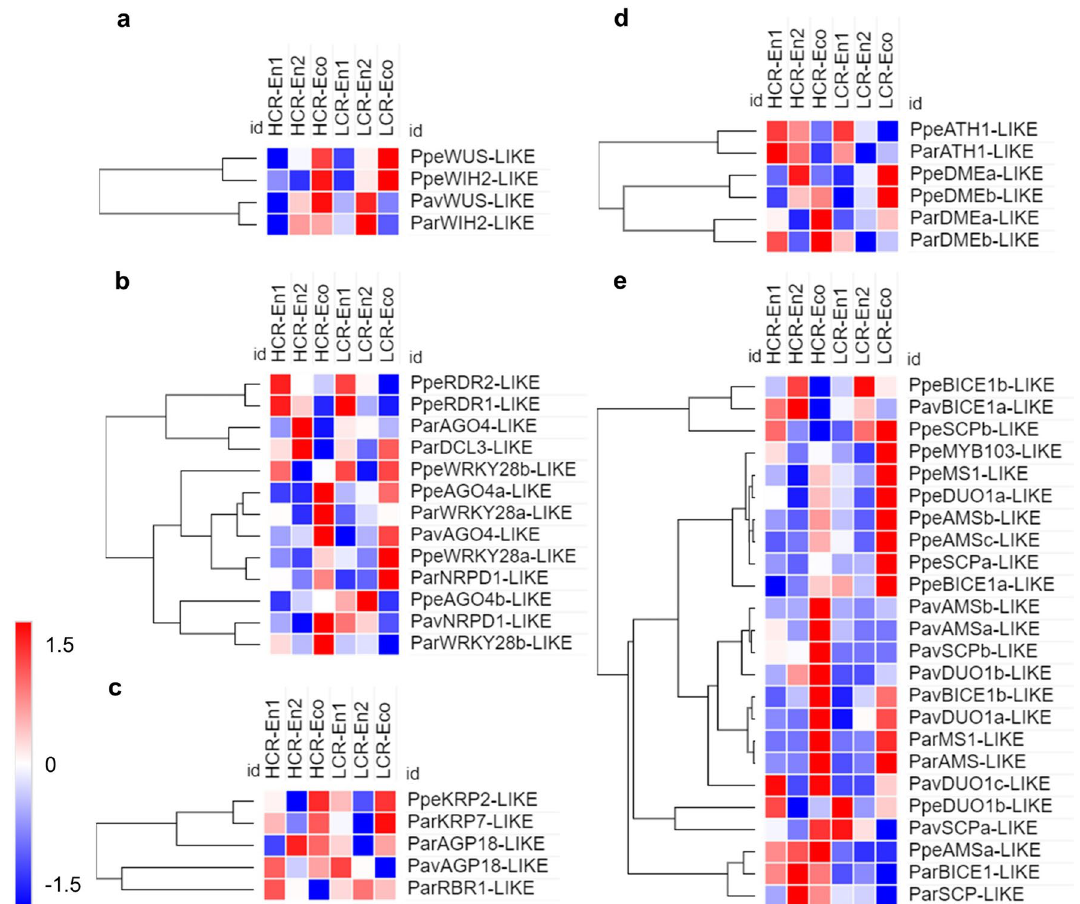
Figure 4. Expression profiles of differentially expressed genes involved in megasporogenesis ( a – d ) and microsporogenesis ( e ) during endodormancy entrance (En1), endodormancy release (En2) and ecodormancy (Eco) in peach (Ppe), apricot (Par) or sweet cherry (Pav). For each species HCR and LCR genotypes are considered. z-score scaled DEGs expression levels are reported in red to blue color scale, corresponding to higher and lower expression,